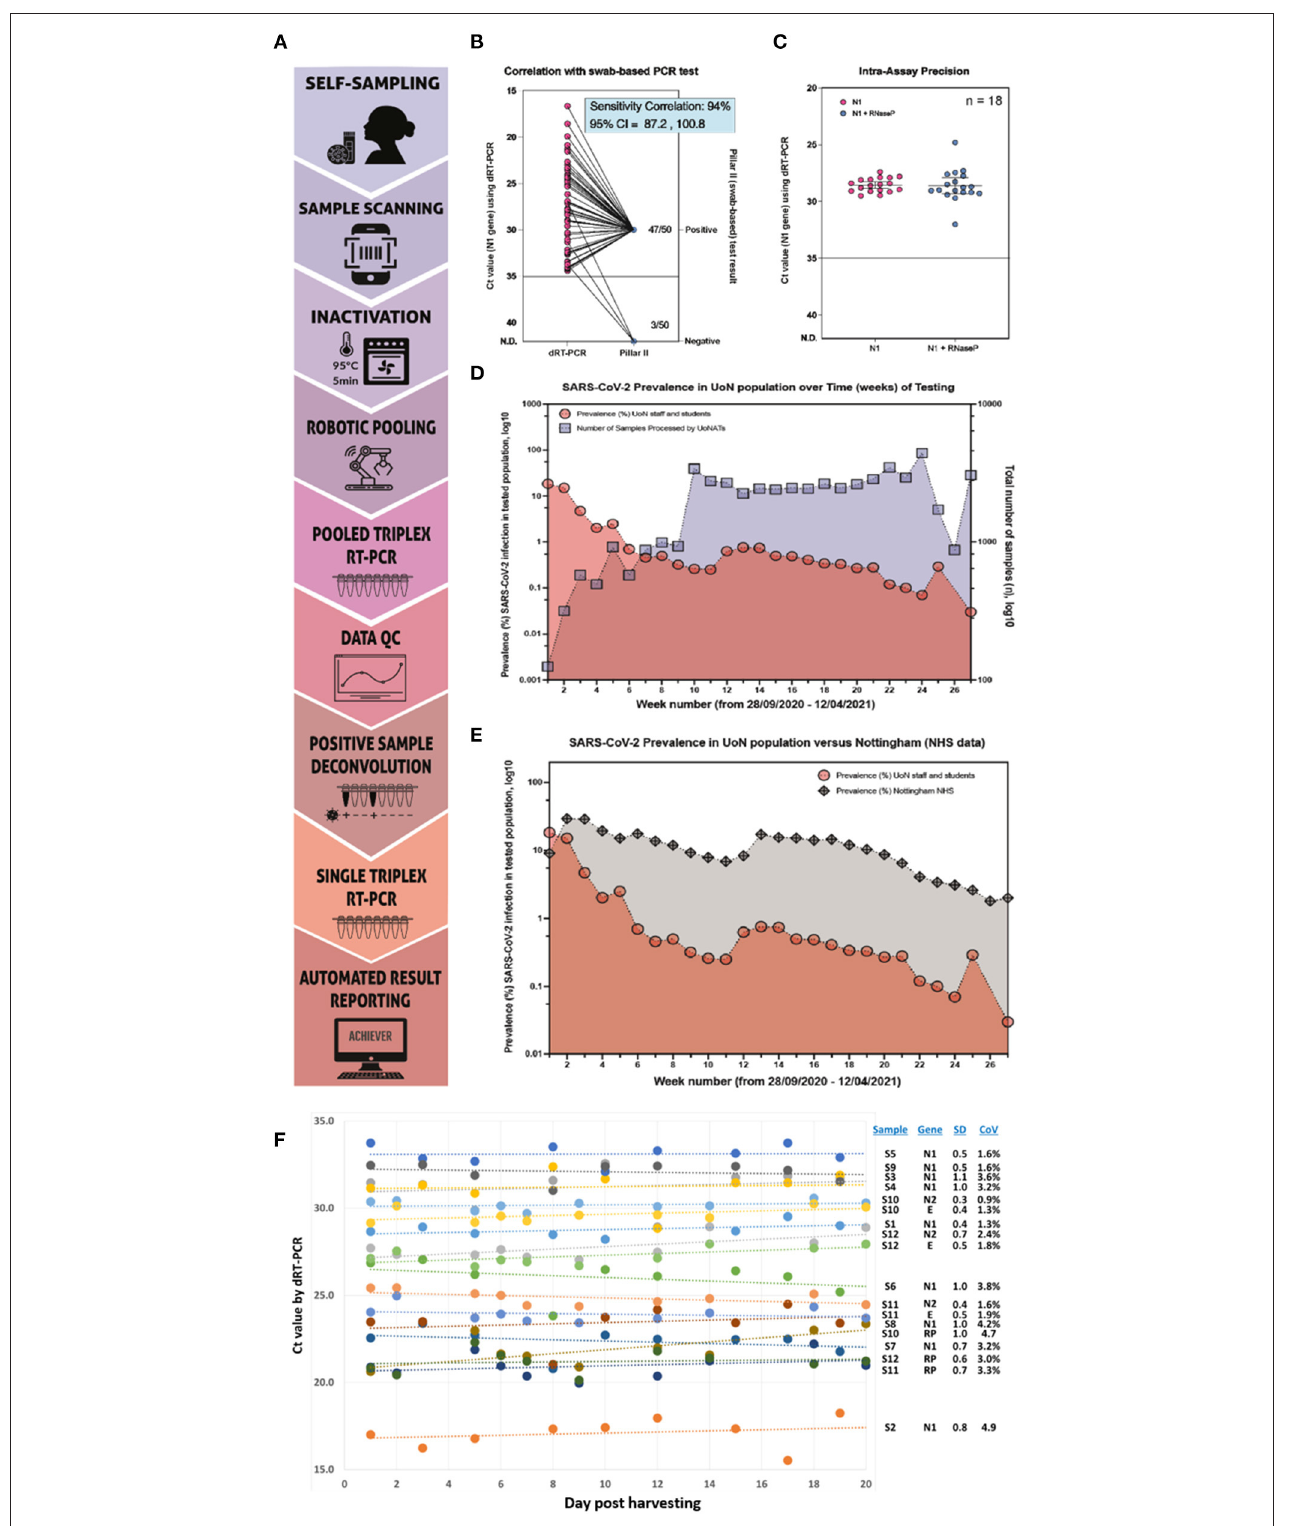
FIGURE 1 | Saliva-based RT-qPCR detection of SARS-CoV-2 is a reliable diagnostic method. (A) A Stepwise testing process: (i) Self-sampling of saliva into a barcoded vial; (ii) Donor scans barcode using their personal devices (e.g., smartphone) and enter information to secure database; (iii) Batch inactivation and lysis